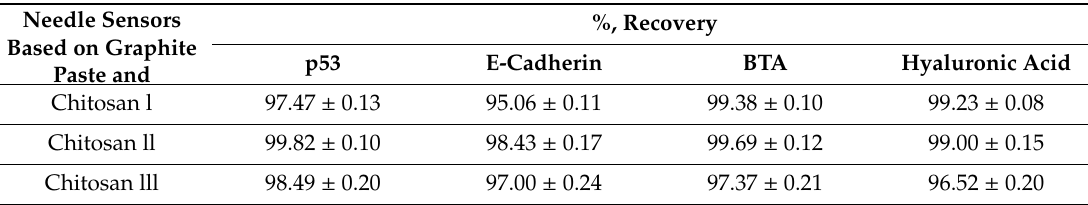
Table 2. The recovery of p-53, E-cadherin, BTA, and hyaluronic acid in spiked samples using the stochastic needle